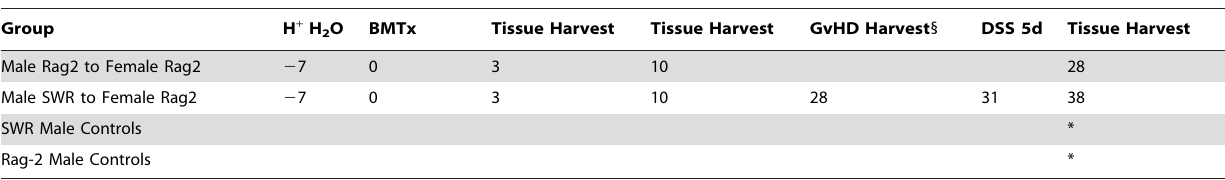
Table 3. Experimental